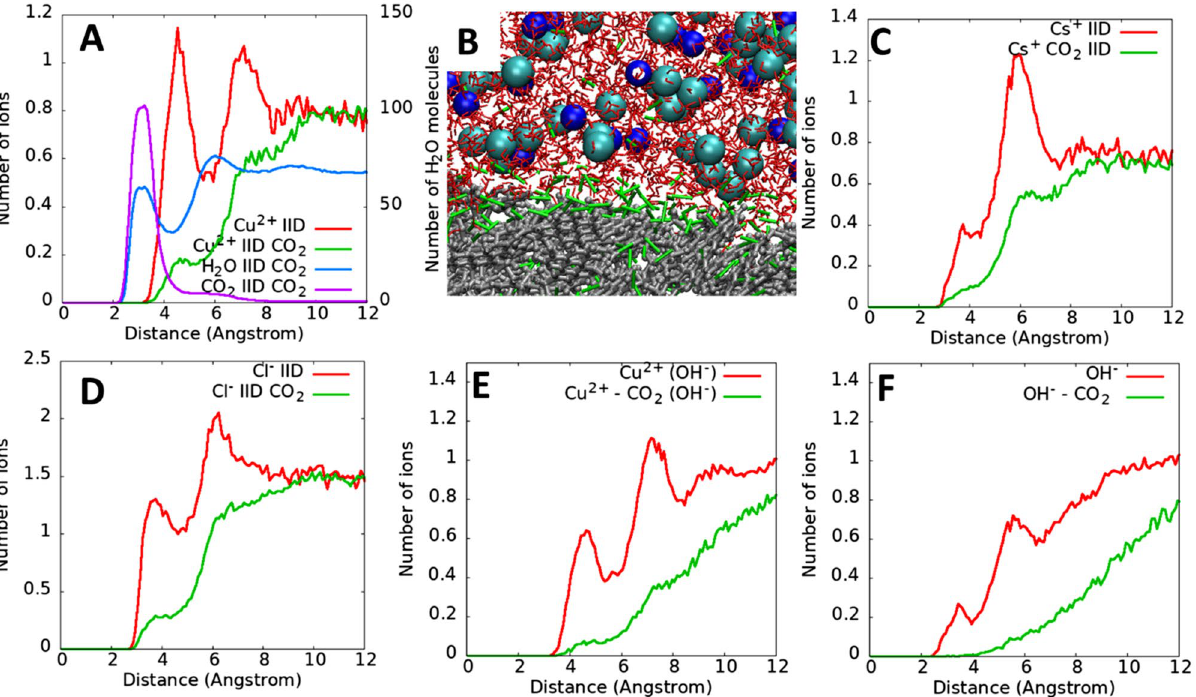
Figure 4. Number of Cu 2+ as a function of distance from the closest kerogen IID surface atoms for the IID- CuCl 2 (red line) and IID-IID-CuCl 2 -CO 2 (green line) systems ( A ). Distributions of water and CO 2 molecules are also shown for the IID-CuCl 2 -CO 2 system. The simulation snapshot demonstrates the adsorption of CO 2 (green) on kerogen (silver) in aqueous solution (water: red, Cu 2+ : blue, Cl − : cyan) ( B ). Distribution of Cs + ( C ) and Cl − ( D ) ions on kerogen IID in the presence/absence of CO 2 . Distribution of Cu 2+ ( C ) and OH − ( D ) ions on kerogen IID in the presence/absence of CO 2 for IID-Cu(OH)Cl-CO 2